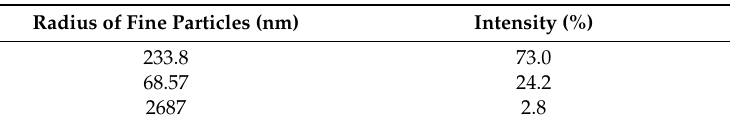
Table 4. Size classes of the fine